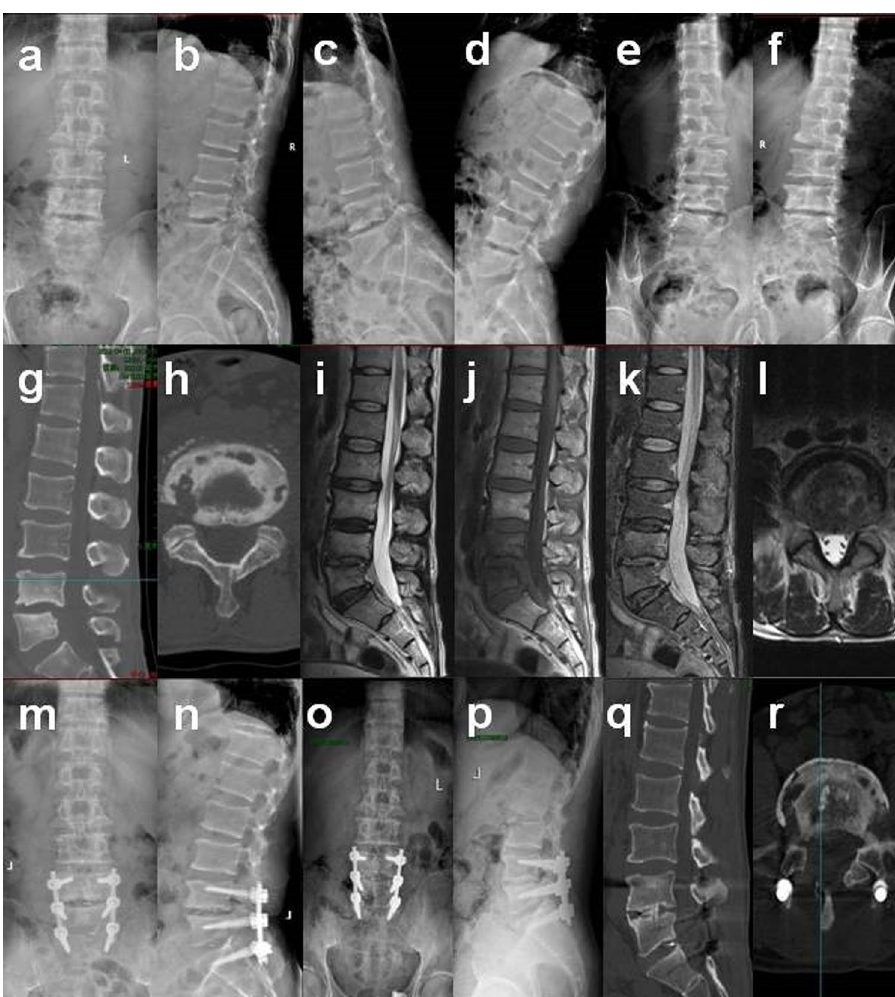
Figure 2. Preoperative and postoperative imaging findings of typical patients. ( a – f ) Preoperative X-ray showed L4 vertebral body posterior slippage and lumbar instability in a dynamic position, and no obvious isthmus was found in a double oblique position. ( g , h ) Preoperative CT showed L4–5, L5–S1 multiple lesions at the upper and lower edges of the vertebral body, especially L4–5. ( i – l ) Preoperative MRI showed L4–5 and L5–S1 uneven abnormal signal changes in the vertebral body and intervertebral disc. ( m , n ) Two weeks after the operation, X-ray showed L4 spondylolisthesis reduction. ( o , p ) One year after the operation, the X-ray showed no apparent loss of spondylolisthesis reduction, and the spine was stable. ( q , r ) One year after the operation, CT showed interbody fusion had been achieved, and the damaged area was repaired